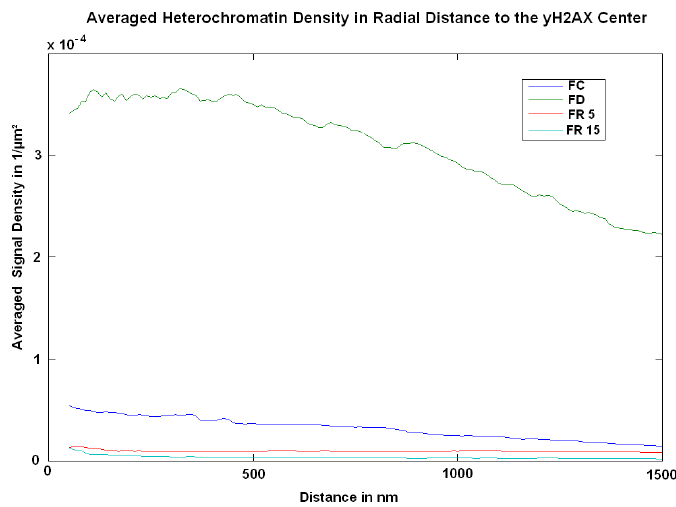
Figure 5. Median numbers of H3K9me3 signals for 4 different preparation conditions.